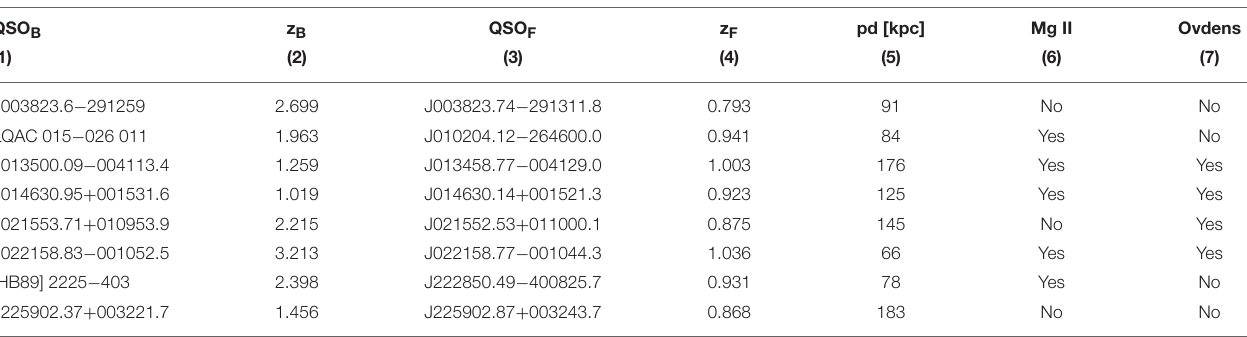
TABLE 1 | List of targets observed in I band.